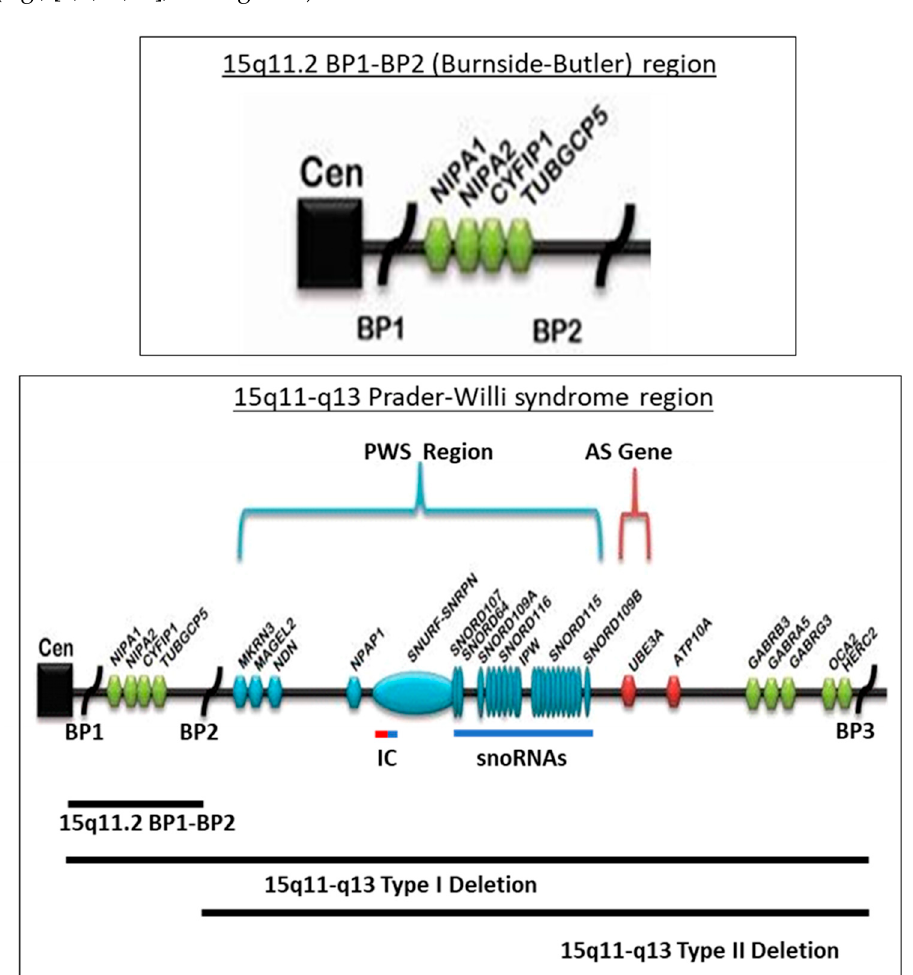
Figure 2. Chromosome 15q11-q13 region with gene and transcript symbols in blue and the location causing Prader–Willi syndrome (PWS) imprinted with paternal expression. Angelman syndrome (AS) and maternal expression is in red, including the causative AS gene (UBE3A ). The non-imprinted genes are green. The three 15q11-q13 breakpoints (BP1, BP2 and BP3) are the sites for the three chromosome 15q deletions; the larger Type I at BP1 and BP3, smaller Type II at BP2 and BP3 and the 15q11.2 BP1-BP2 deletion alone designated as Burnside–Butler syndrome. IC designates the imprinting center that controls the activity of the imprinted genes in the region and dependent on the parent of origin. The 15q11.2 BP1-BP2 region is enlarged and illustrated at the top. Prader–Willi syndrome is recognized as the first example of genomic imprinting in humans with dozens of genes and transcripts identified and located between chromosome 15q11-q13 breakpoints BP1 and BP3 flanked by low copy repeats prone to non-homolo- gous recombination that leads to PWS. Genes in this 15q11-q13 region are both imprinted ( NDN , MAGEL2 , MKRN3 , SNURF-SNRPN , SNORDs , UBE3A , ATP10A ) and non-im- printed ( NIPA1 , NIPA2 , CYFIP1 , TUBGCP5 , GABA receptors, OCA2 albinism). There are 165 recognized human and 197 mouse genes currently known to be imprinted or active depending on the parent of origin. Several genes in the 15q11-q13 region have been im- plicated in neurodevelopment and function with a role in behavior and learning, ataxia, hyperphagia and obesity, magnesium transportation, hypogonadism and precocious pu- berty, circadian rhythm, autism and skin pigment production with albinism [1,2,7,17,24– 28]. Information about the functional status of chromosome 15 genes, both imprinted and non-imprinted have been characterized. Specifically, the NDN (neurally differentiated EC